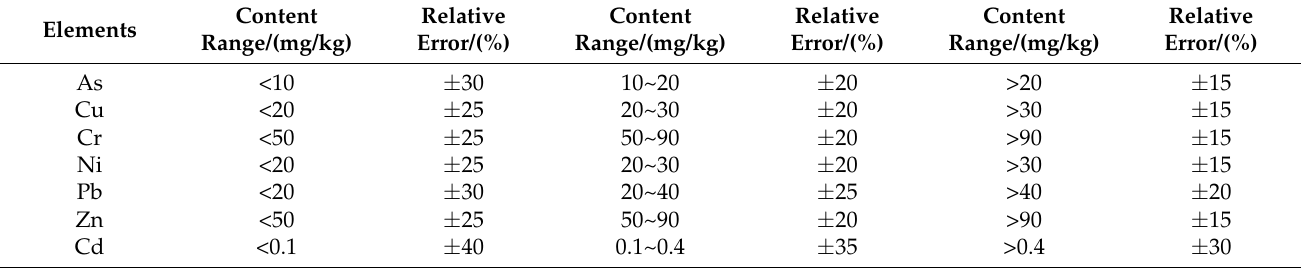
Table A3. Allowable range of test correctness as defined by The Soil Contamination of Agricultural Land Detailed Investigation of Quality Assurance and Quality Control Technology